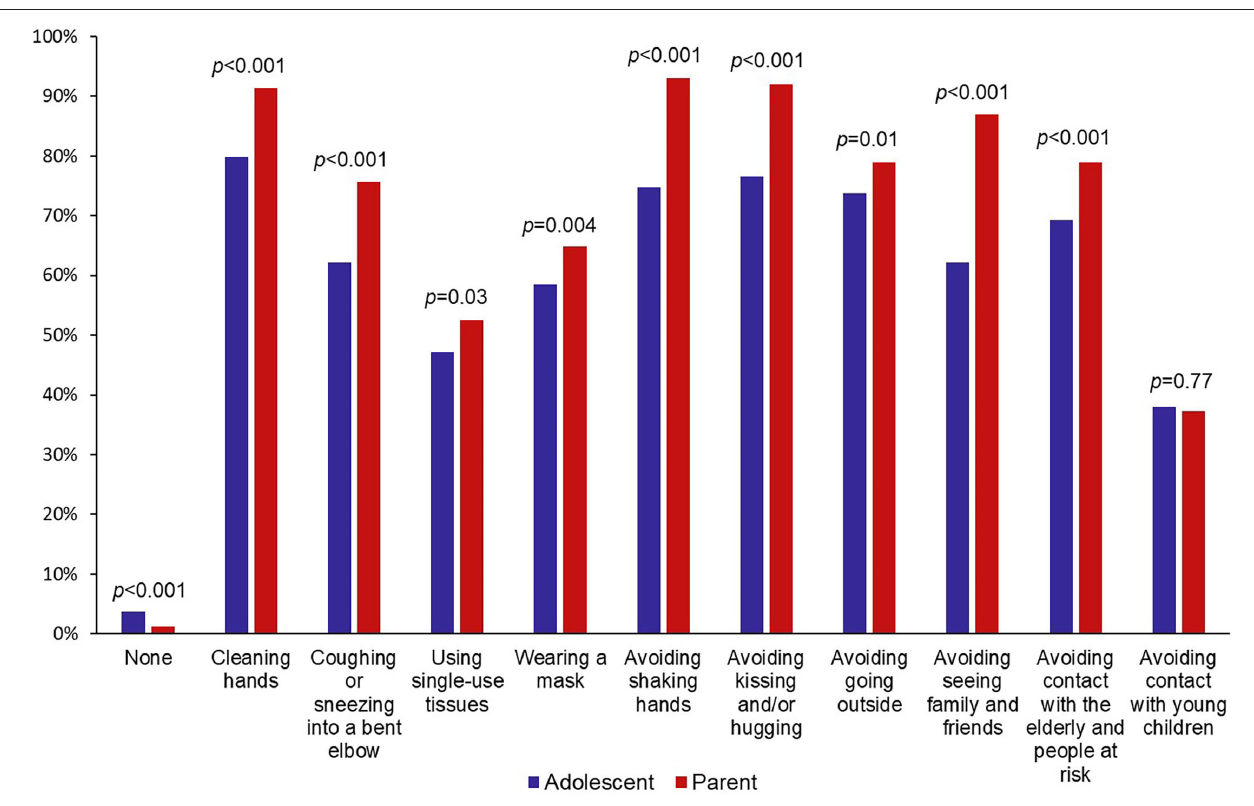
FIGURE 1 | Implementation and reinforcement of COVID-19 preventive measures for adolescents and their parents in the PARIS birth cohort during lockdown.